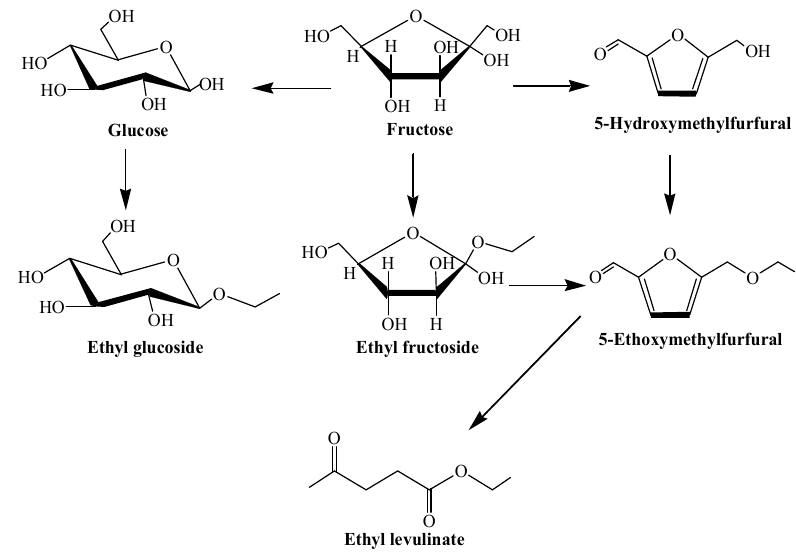
Scheme 1. Reaction pathways for the conversion of fructose in ethanol medium over metal salts.